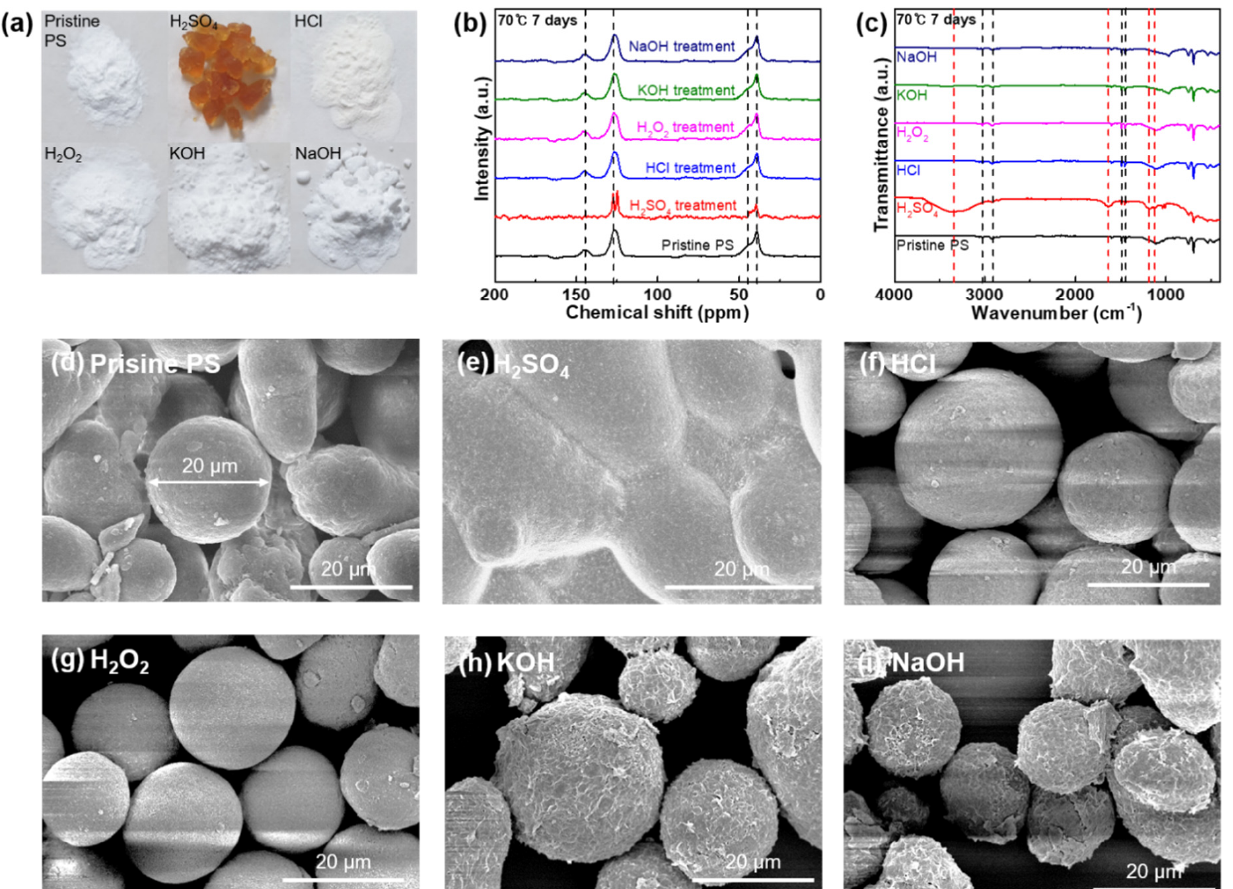
Figure 4. ( a ) Photograph of the PS samples in the pristine state and after chemical stability tests against strong acids, bases, and oxidizing agents (H 2 SO 4 , HCl, H 2 O 2 , KOH, and NaOH) used in the chemical digestion procedure at 70 °C for 7 d. ( b ) 13 C NMR spectra of PS in the pristine state and after the reaction with all chemical agents at 70 °C for 7 d. ( c ) FT-IR spectra of PS in the pristine state and after the reaction with all chemical agents at 70 °C for 7 d. ( d ) SEM image of the pristine PS microparticles. SEM images of the PS microparticles after the reaction with ( e ) H 2 SO 4 , ( f ) HCl, ( g ) H 2 O 2 , ( h ) KOH, and ( i ) NaOH at 70 °C for 7 d.